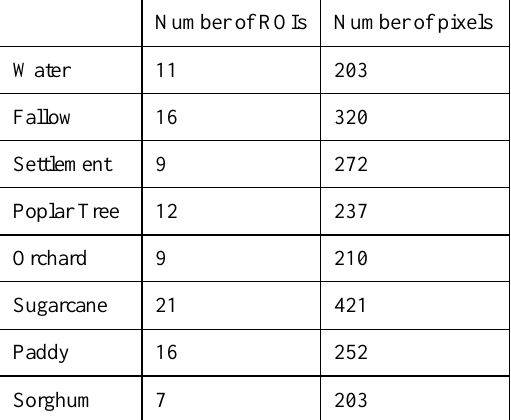
Table 2. Number of ROIs and Pixels in each